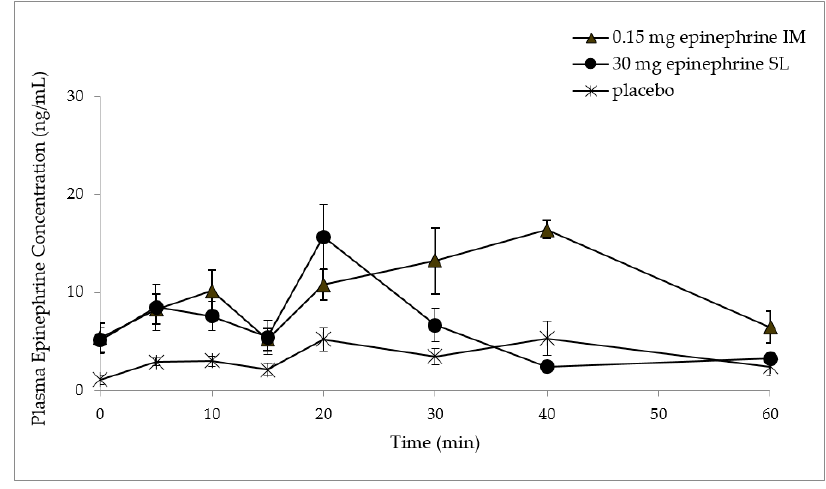
Figure 1. Plasma epinephrine concentration (mean ± SEM) versus time plots following the administration of epinephrine 0.15 mg by intramuscular injection, epinephrine 30 mg sublingually, and placebo sublingually. Table 3. The pharmacokinetic parameters of epinephrine following the sublingual administration of epinephrine 30 mg and placebo tablets and epinephrine 0.15 mg by intramuscular injection in the thigh.